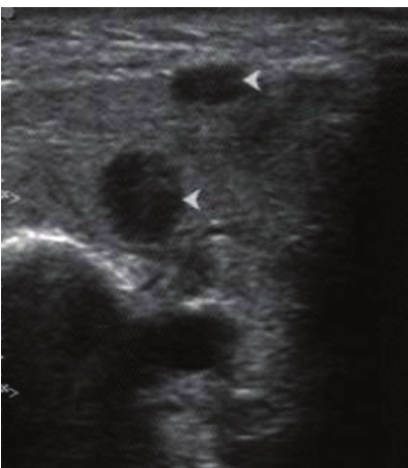
Figure 4: One of the hypoechoic lesions is protruding to the exterior of the gland parenchyma. The arrowheads show the surface breach through which the lesion has entered the extraglandular space.